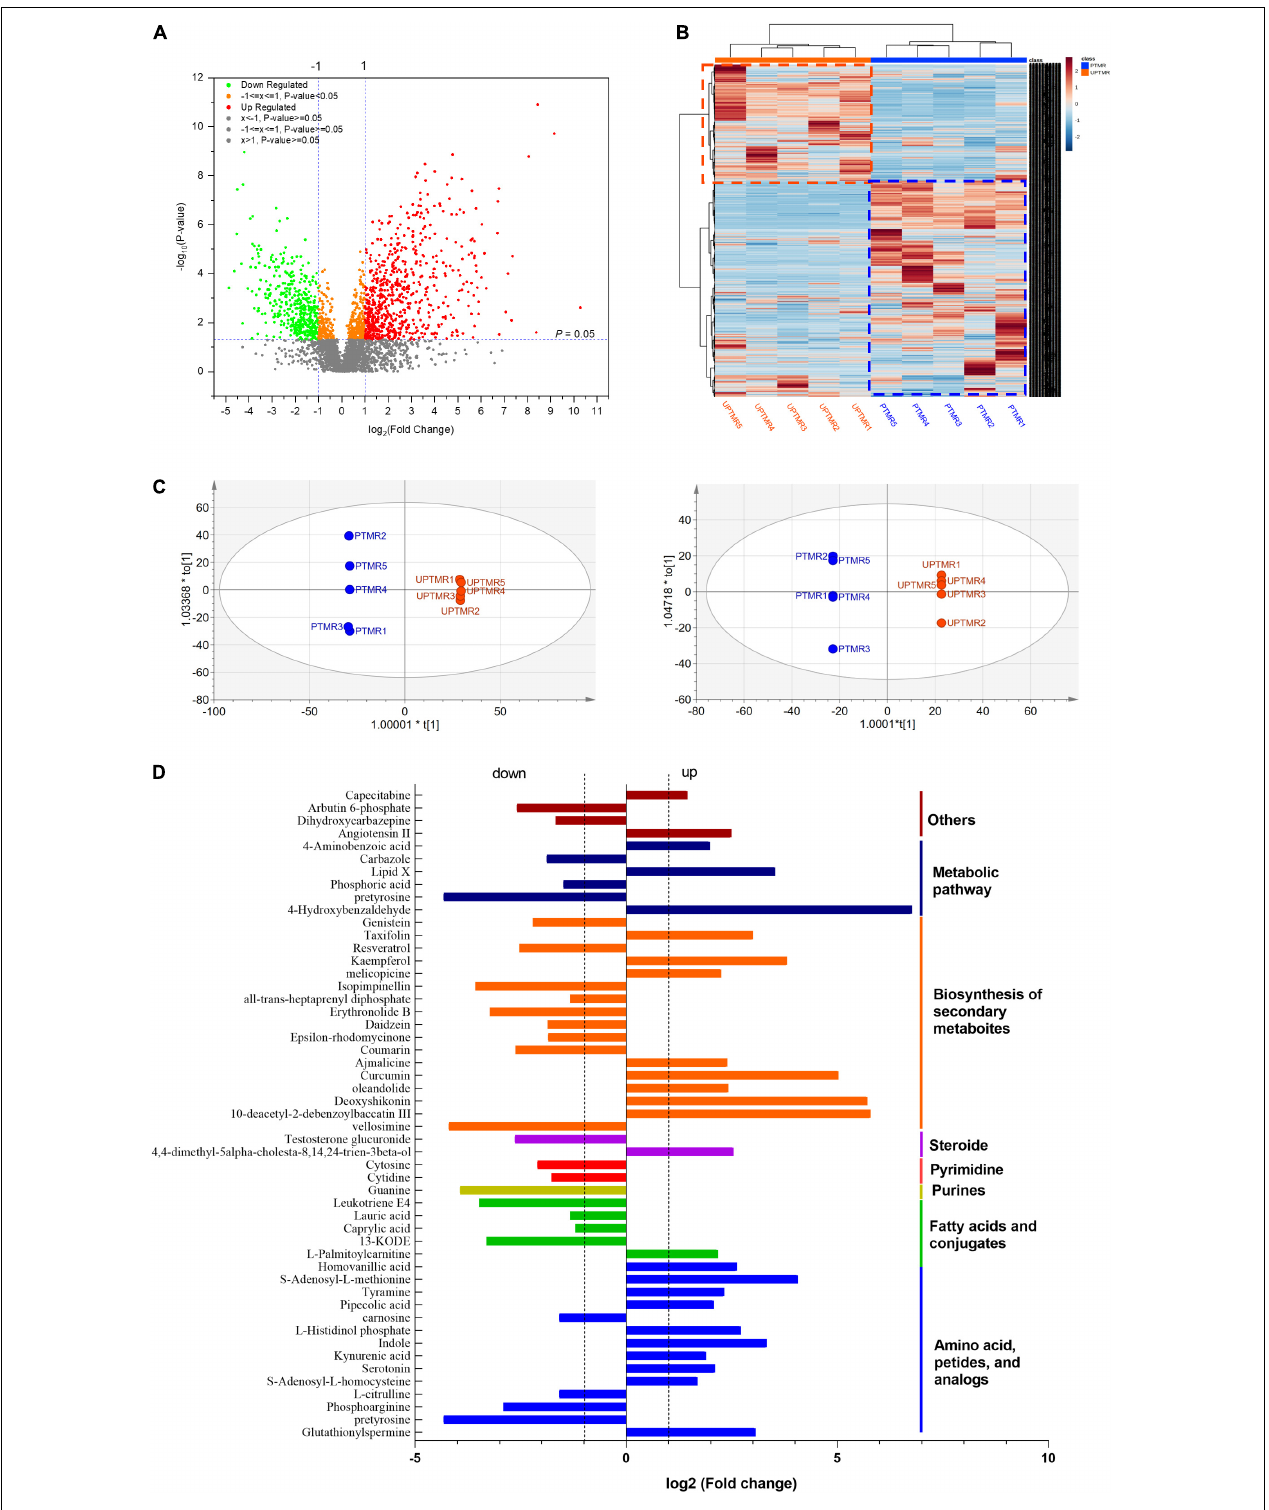
FIGURE 3 | (A) Volcano plot shown the profile of metabolites and discrepant metabolites between the PTMR and UPTMR groups. (B) Heatmap indicated effects of the dietary form (PTMR vs. UPTMR) on the ruminal metabolites of lambs. (C) The orthogonal projections to latent structures discriminant analysis (OPLS-DA) to the ruminal metabolites of the PTMR and UPTMR groups. (D) The classifications of discrepant metabolites ( P < 0.05) with upregulated or downregulated in the PTMR group compared with those of the UPTMR group.